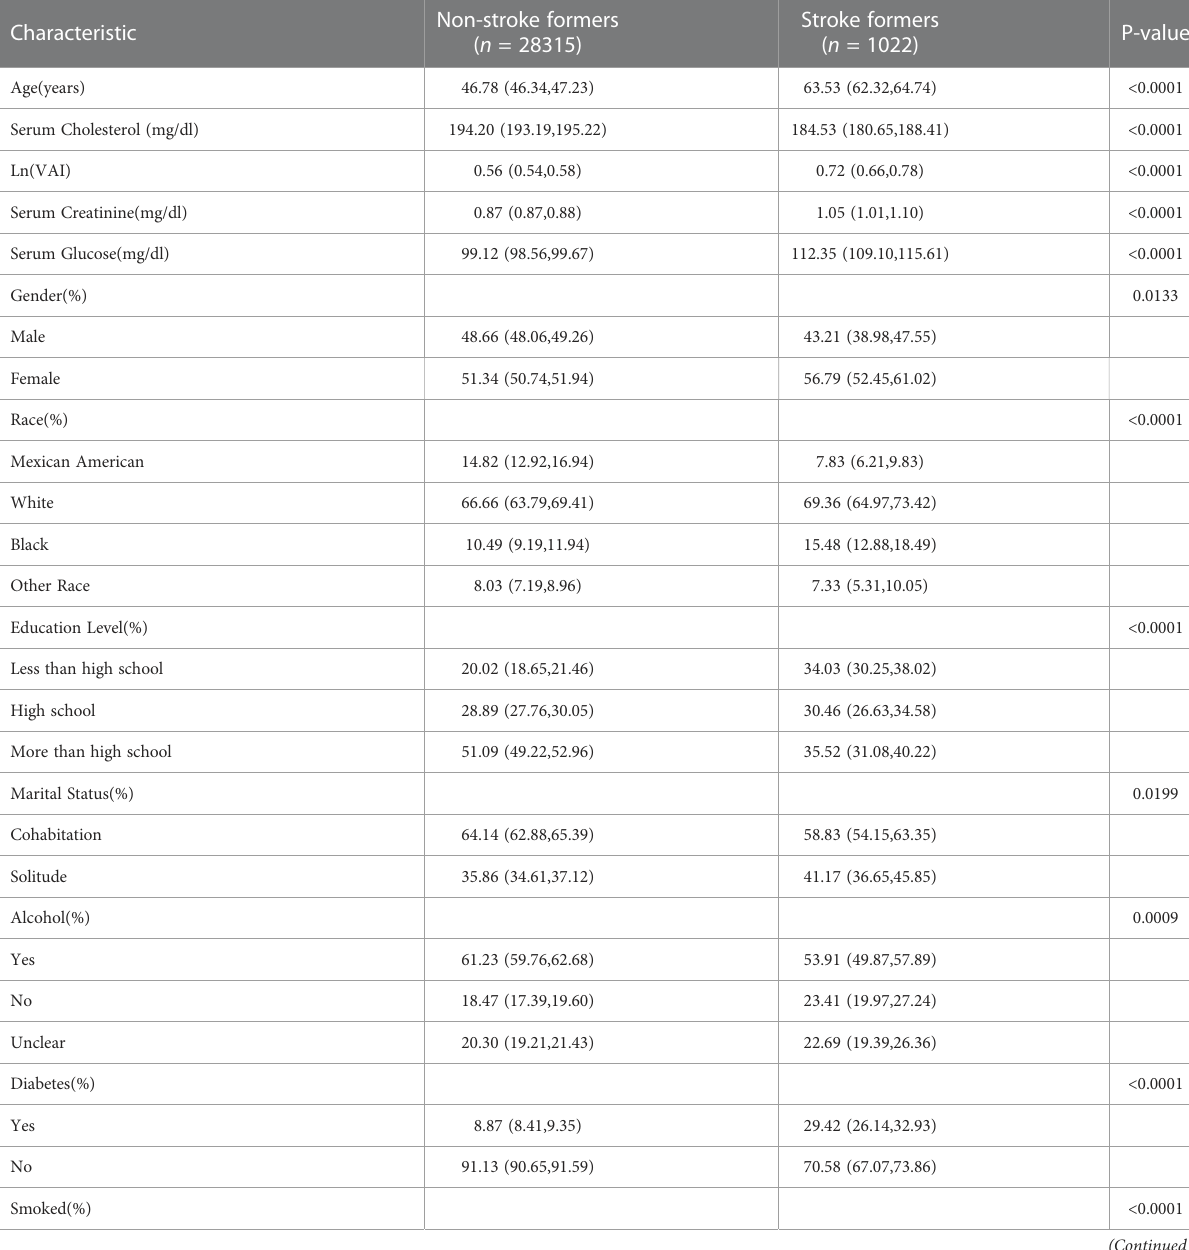
TABLE 1 Baseline characteristics of participants,